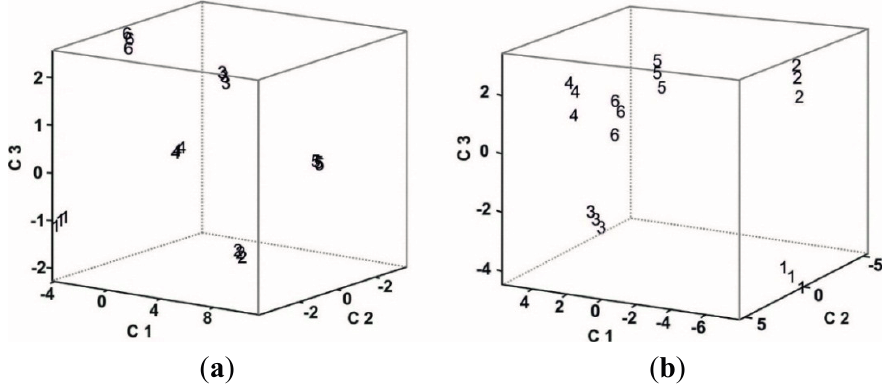
Figure 7. PARAFAC scores plot of the array obtained from ( a ) The voltammetric responses; ( b ) The mass responses. Must samples are 1: Prieto Picudo; 2: Garnacha; 3: Cabernet Saugvinon; 4: Tempranillo; 5: Juan García; and 6: Mencía